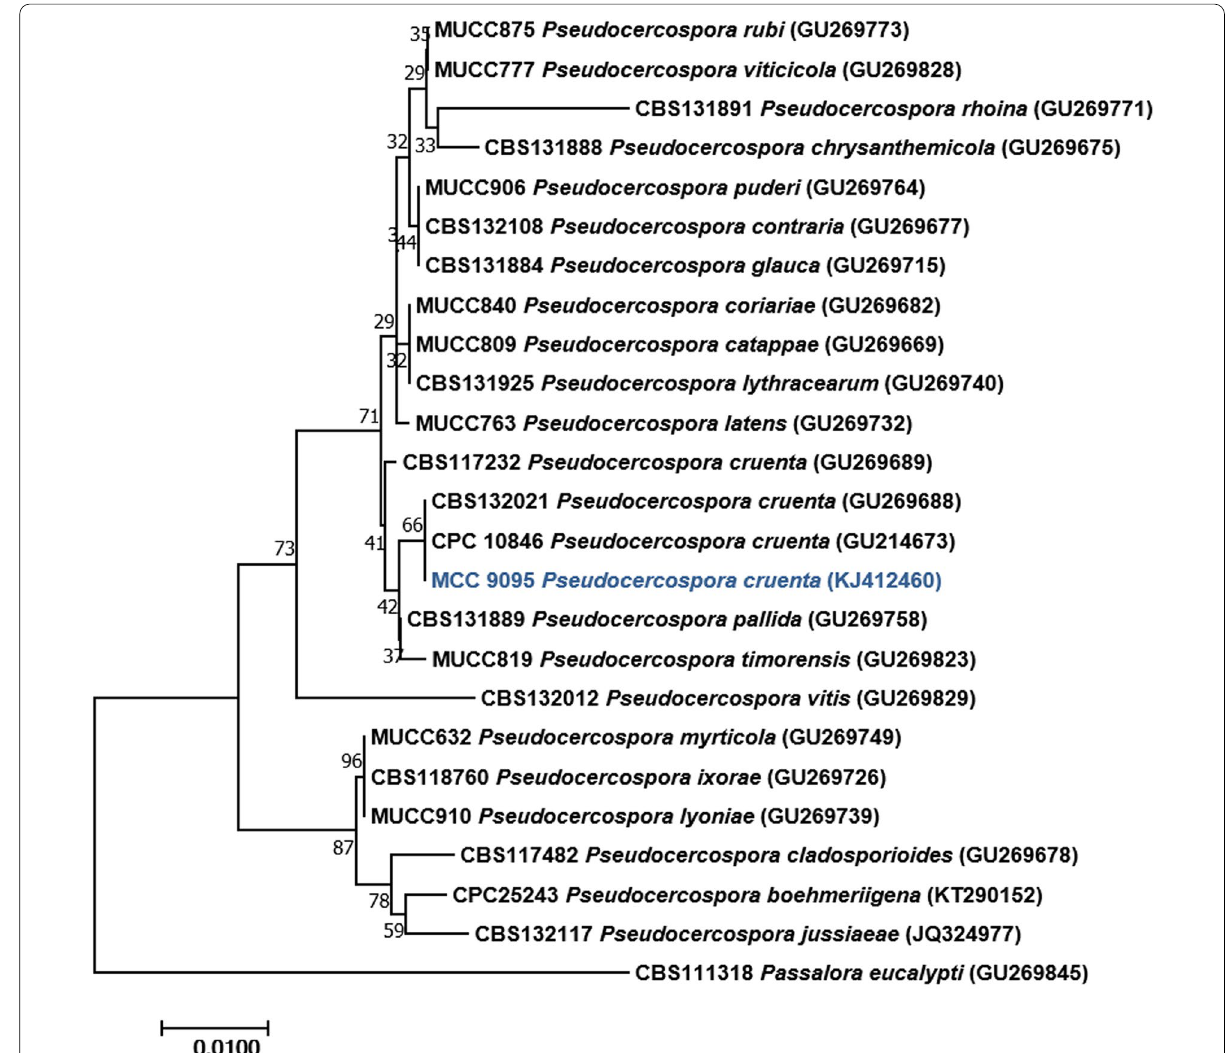
Fig. 10 Neighbor-Joining (NJ) tree based on nrITS sequences to identify the sequenced Pseudocercospora cruenta (shown in bold). Sequence alignments were produced using MAFFT v. 7.0 and the phylogenetic tree was constructed using MEGA v. 7.0. The tree was rooted to Passalora eucalypti . Bootstrap support values from 1000 replicates are shown at the nodes. Bar